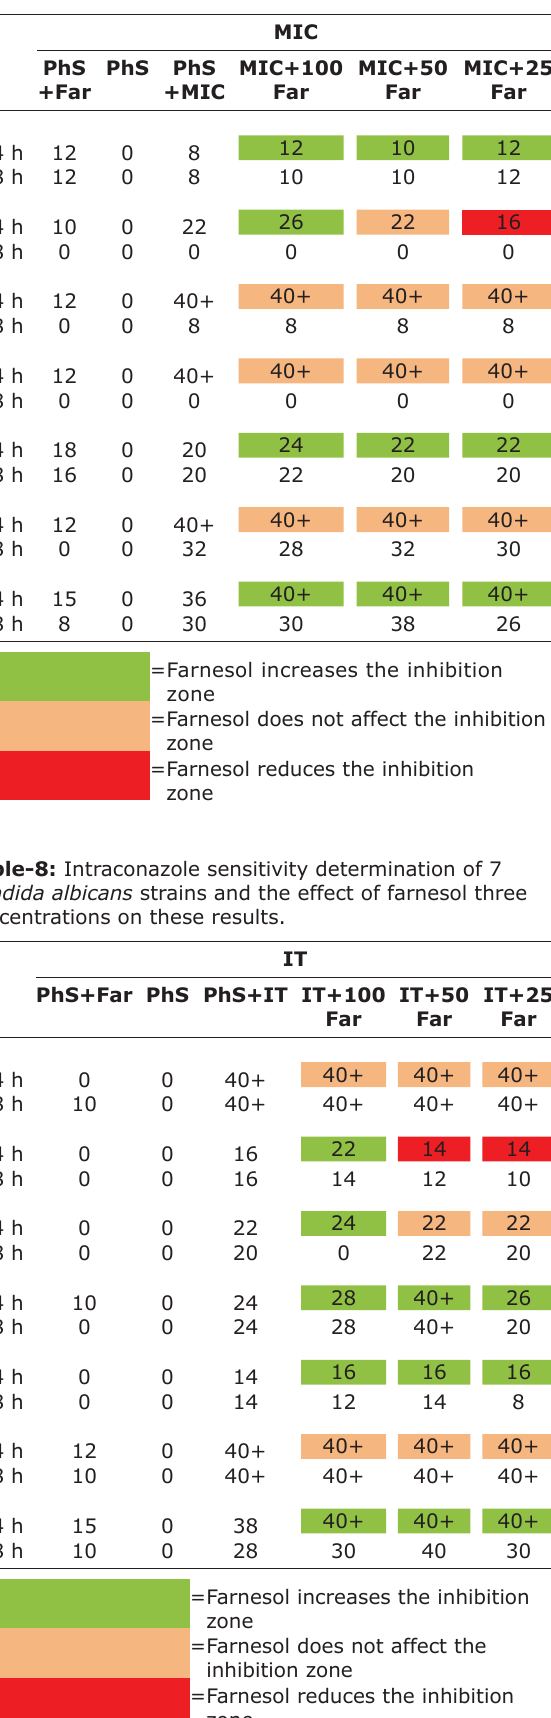
Table-7: Miconazole sensitivity determination of 7 Candida albicans strains and the effect of farnesol three concentrations on these results.